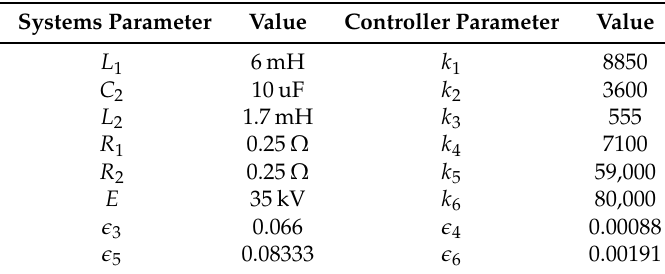
Table 1. Parameter values and simulation model